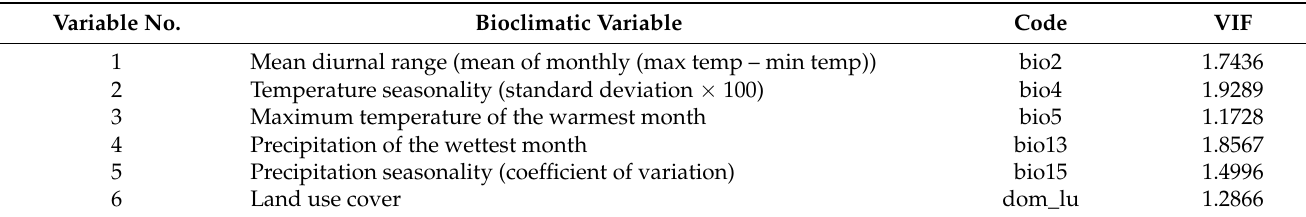
Table 1. Climatic variables retained after correlation analysis using variance inflation factors (VIF).